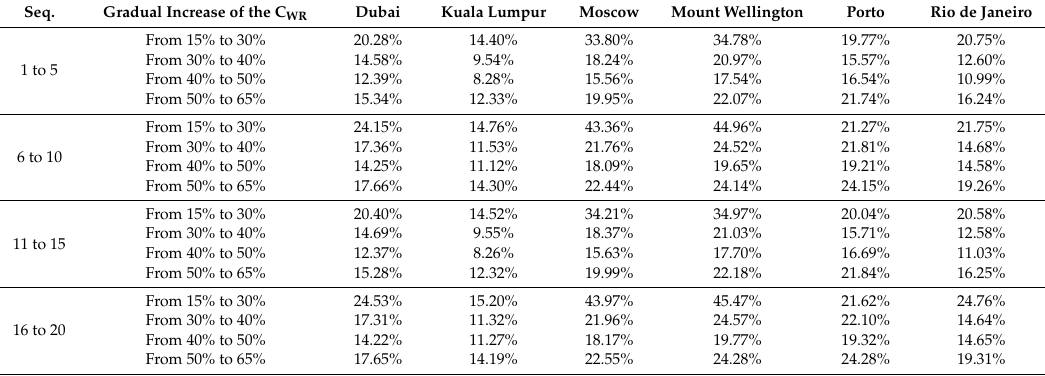
Table 4. The proportional impact of the exterior openings on the EUI in the case study.